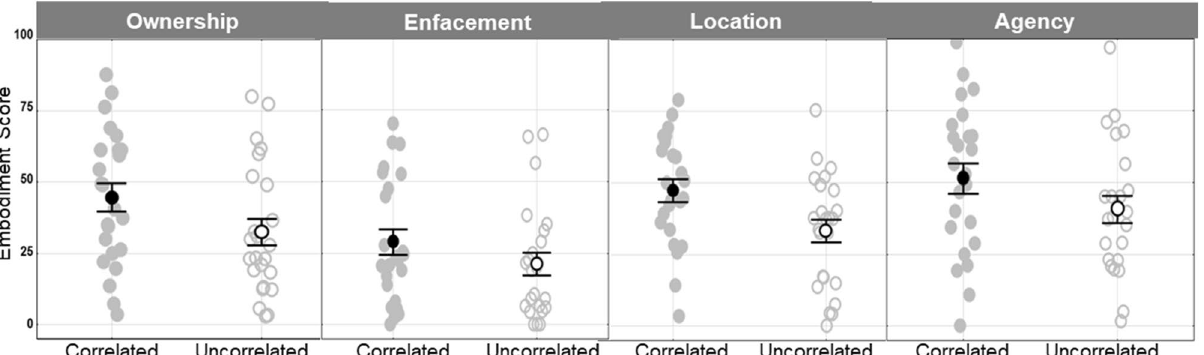
Figure 1. Mean values of the embodiment scores for the ownership, enfacement, location and agency categories as measured in the Correlated and Uncorrelated visuo-tactile stimulation conditions. Note the general increase in the scores in the Correlated as compared to Uncorrelated conditions. Grey points: individual data; Black circles: means; Bars: standard